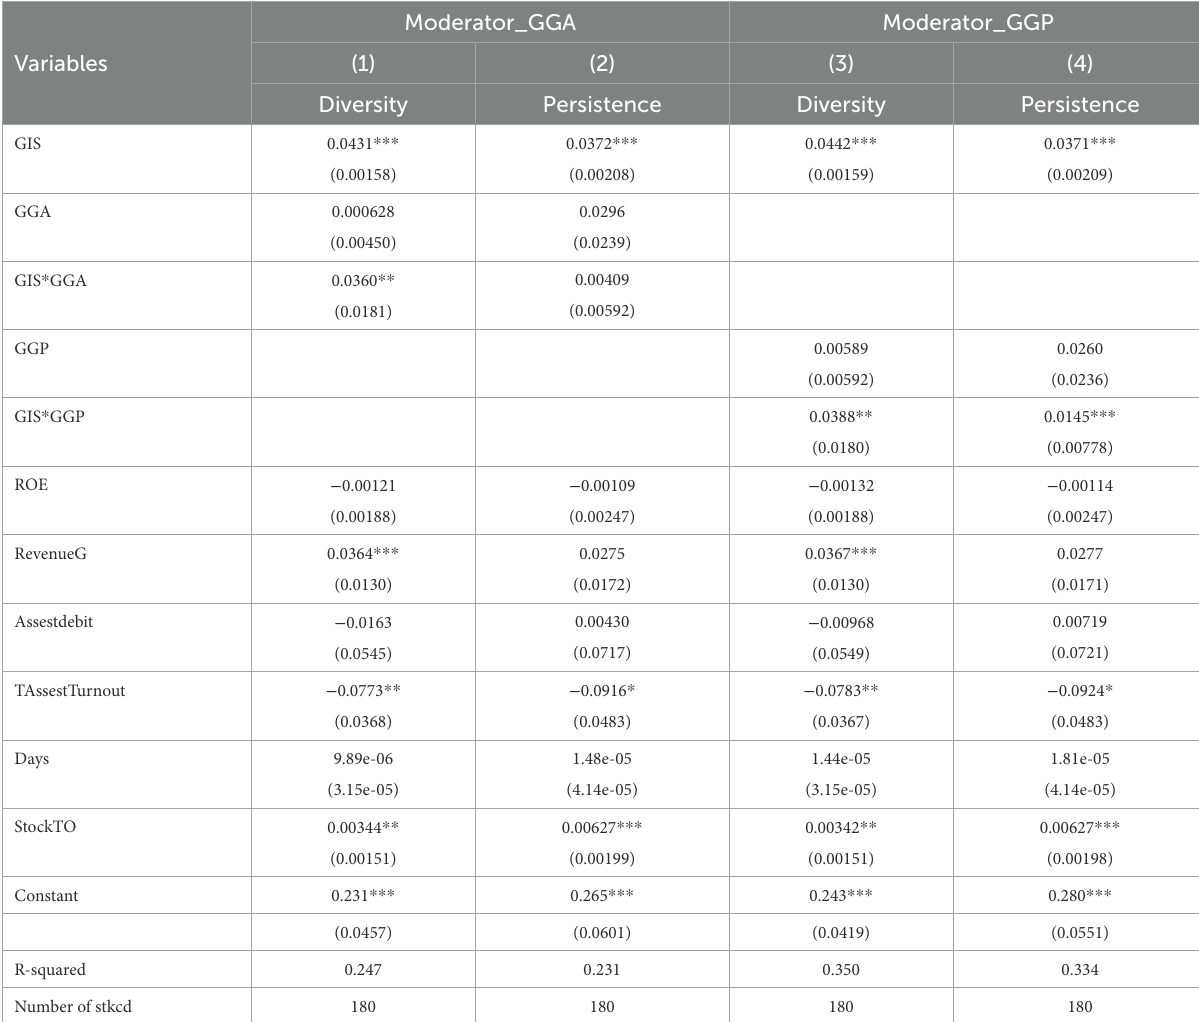
TABLE 6 Empirical results of executives’ academic experience as